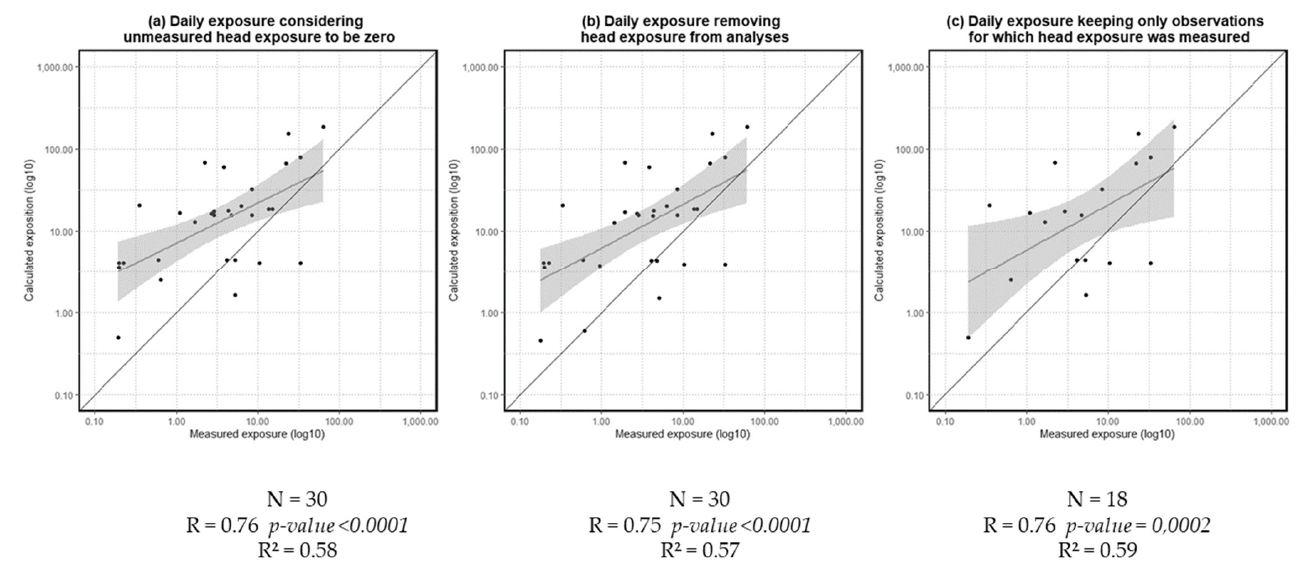
Figure A3. Operator Outdoor Spray AOEM worksheet